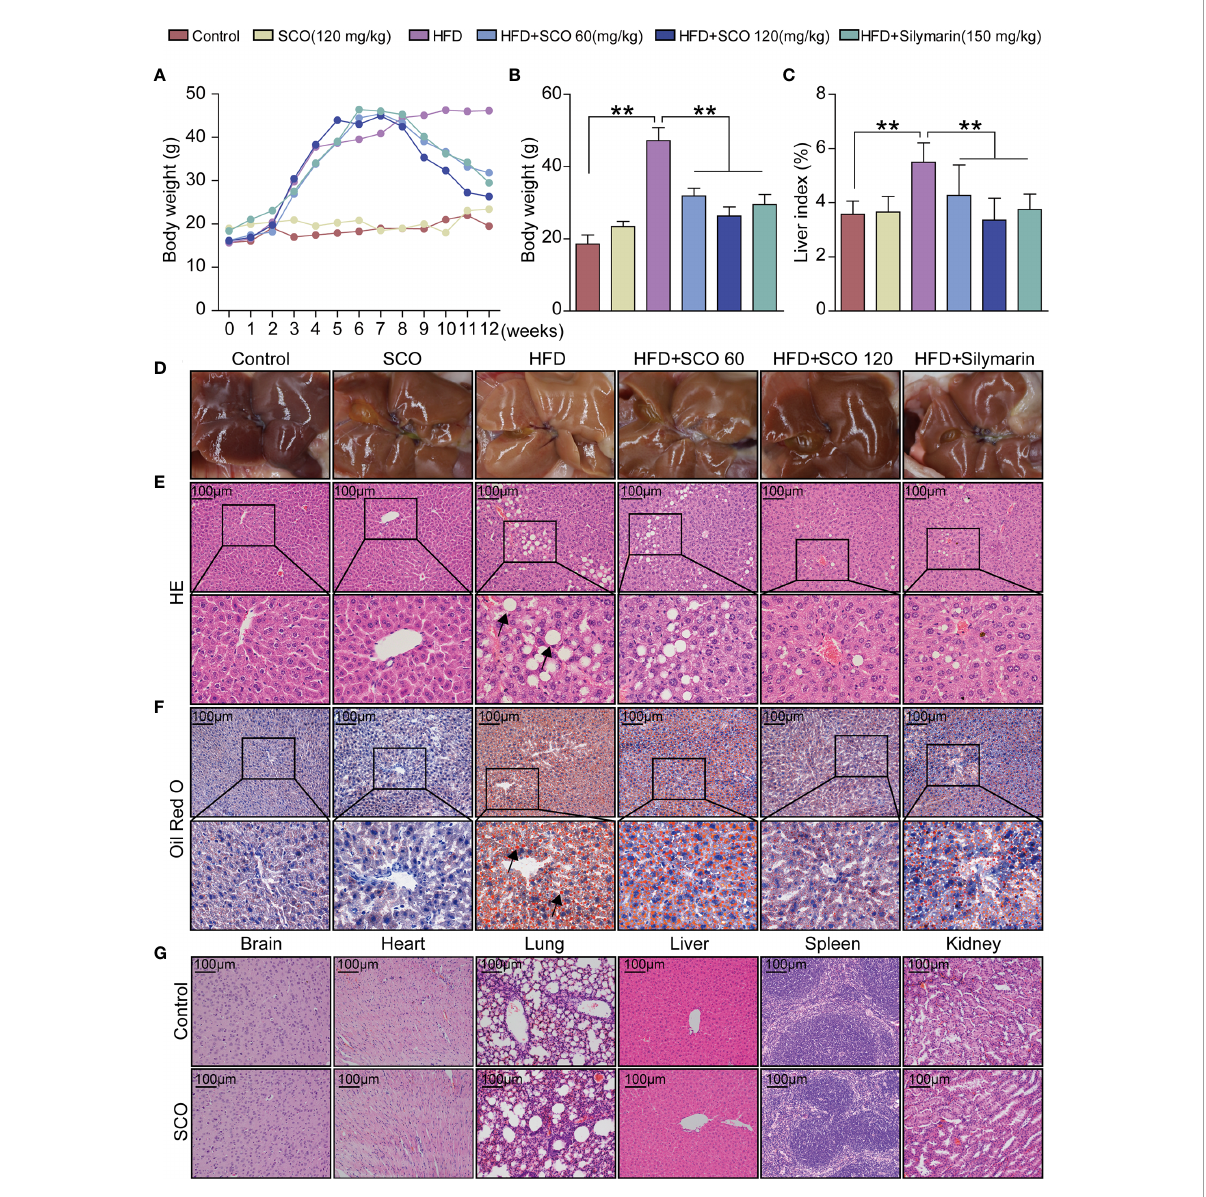
FIGURE 2 Pathological observation of main organs in mice. (A – C) Body weight and liver index of mice. (D) liver morphology. (E, F) Histological photomicrographs of liver sections stained with HE or Oil Red O (Scale bar = 100 m m), fat vacuoles and fatty degeneration (black arrow). (G) Histological photomicrographs of brain, heart lung, liver, spleen, kidney sections stained with HE (Scale bar = 100 m m). The HFD group was compared to the Control group; the HFD + SCO (60, 120 mg/kg) groups and HFD + Silymarin group were compared to the HFD group, ** P <